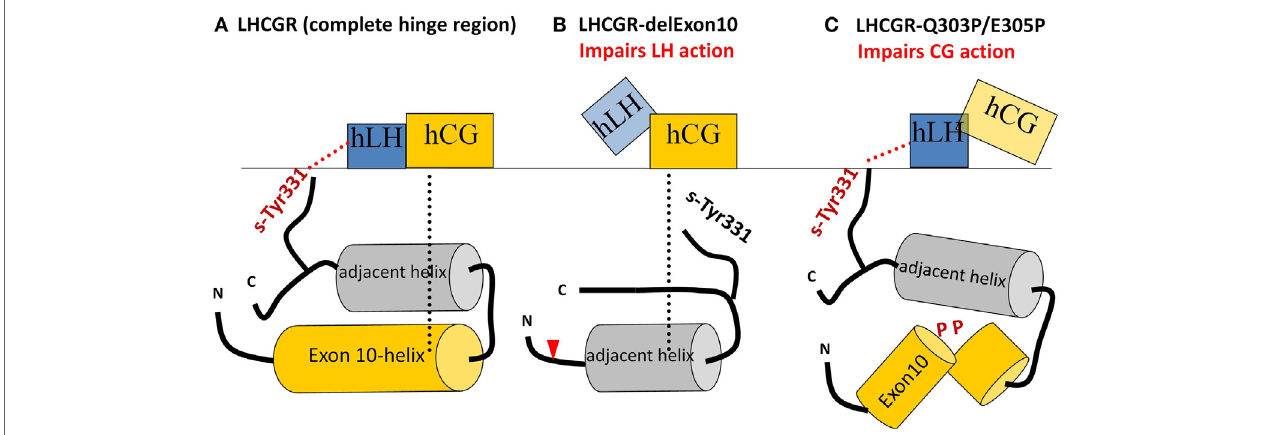
FigUre 7 | sketches of the different hlh and hcg interactions with the middle section of the hinge region with various lhcgr constructs . (a) LHCGR-wt: exon10-helix shifts the sulfated sTyr331 into an appropriate spatial position necessary to interact with hLH, while, for hCG, exon10-helix acts as a structural interface. (B) LHCGR-delExon10: deletion of exon 10 leads to displacement of the remaining residues beyond the cutting point (red triangle). Subsequently sTyr331 abrogates the interaction with hLH, However, the adjacent helix moves into the position previously occupied by the exon 10-helix and thus provides a structural interface for activation by hCG; (c) LHCGR-Q303P/E308P double proline mutation within exon10 disturbs the helical structure of exon10-helix and interferes with the hCG-induced hinge movement and signaling. However, in this case, the retained length of the middle hinge region allows the appropriate adjustment of sTyr331 for proper hLH interaction and